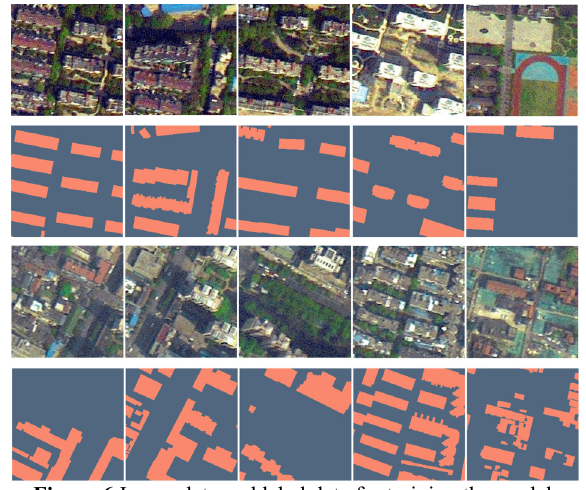
Figure 6 Image data and label data for training the model.